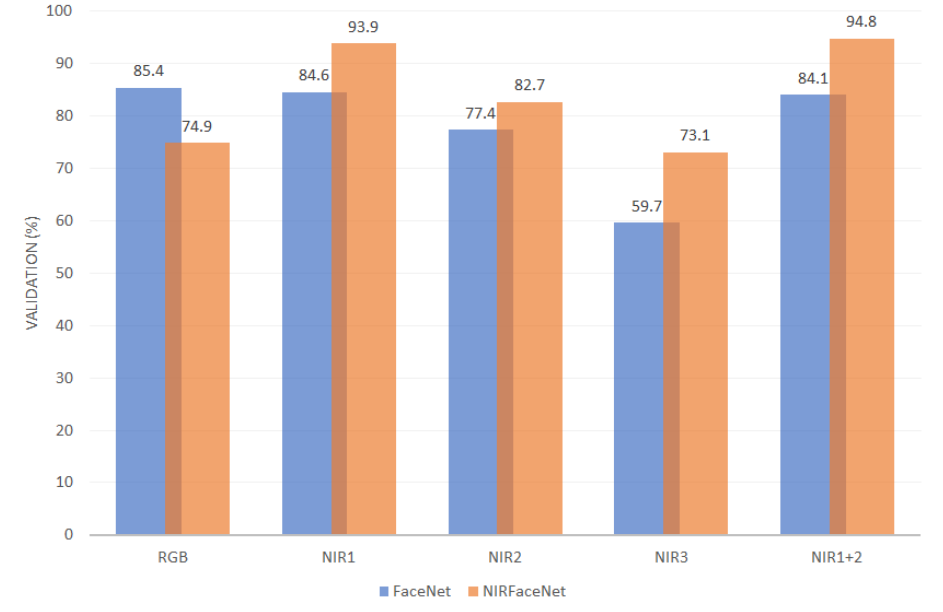
Figure 10. Comparisons between FaceNet and NIRFaceNet